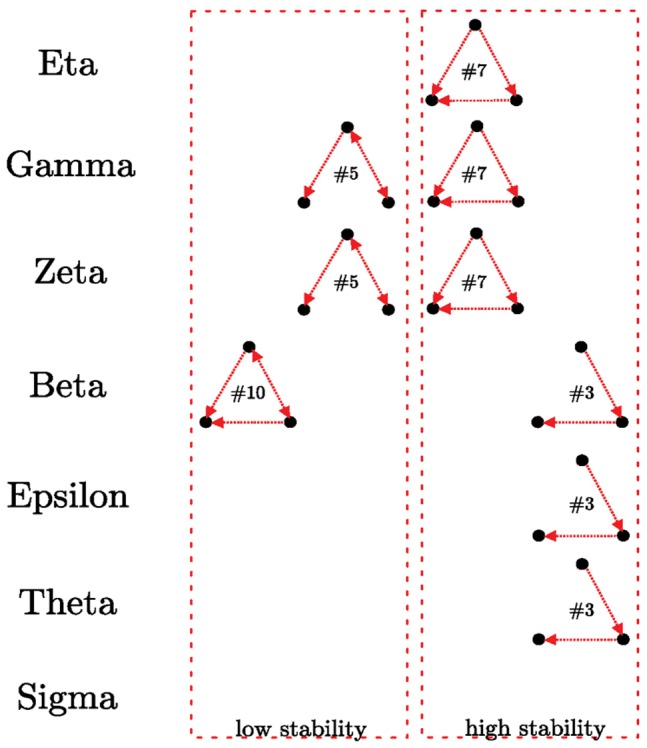
3-nodes statistical significant motifs (p<0.005) that built each isoform specific interaction network.The numbers correspond to the classification described in the motif dictionary by Uri Alon (http://www.weizmann.ac.il/mcb/UriAlon/).